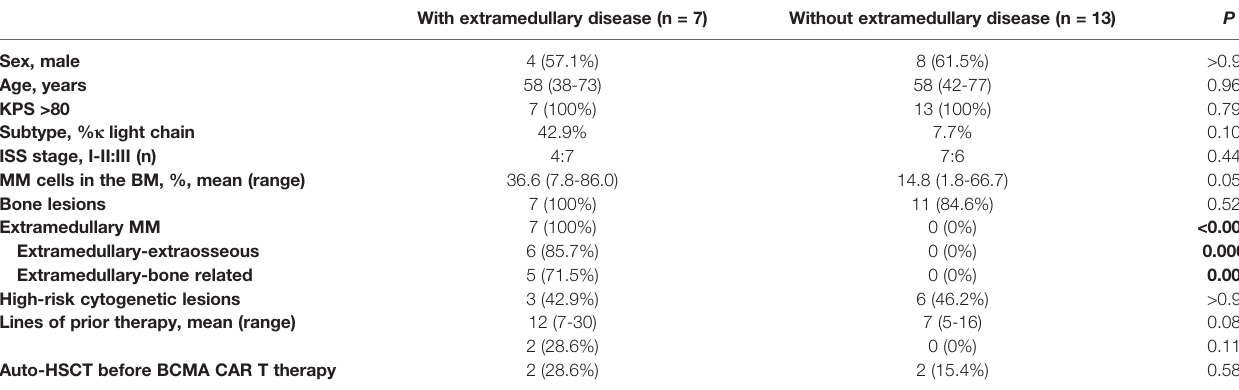
TABLE 2 | To compare the baseline characteristics of the R/R multiple myeloma patients with or without extramedullary disease. With extramedullary disease (n = 7) Without extramedullary disease (n =